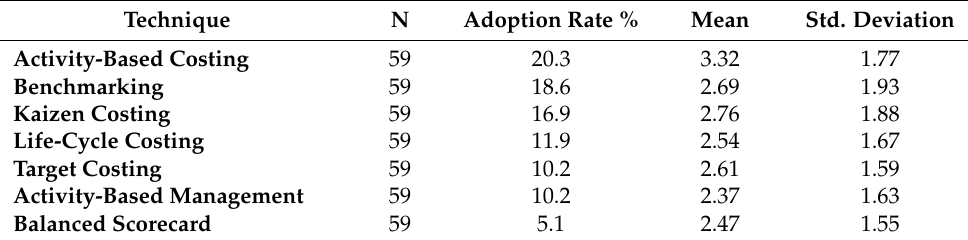
Table 10. Status of MAIs in the non-manufacturing sector in Libya.